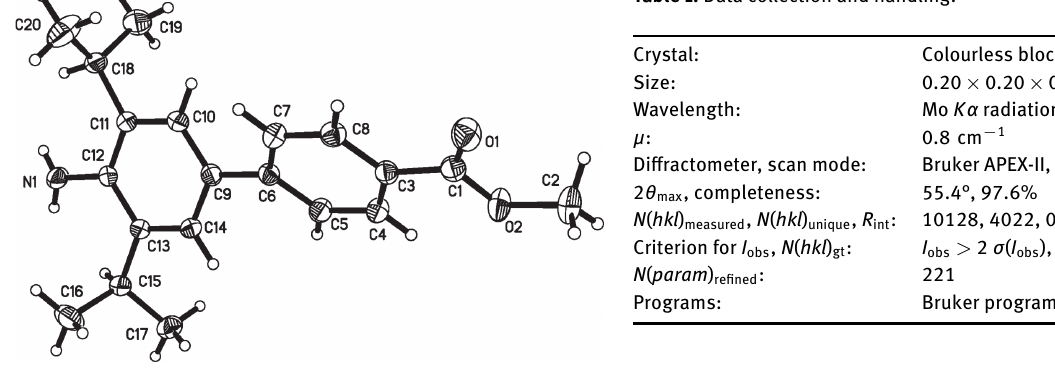
Table 1: Data collection and